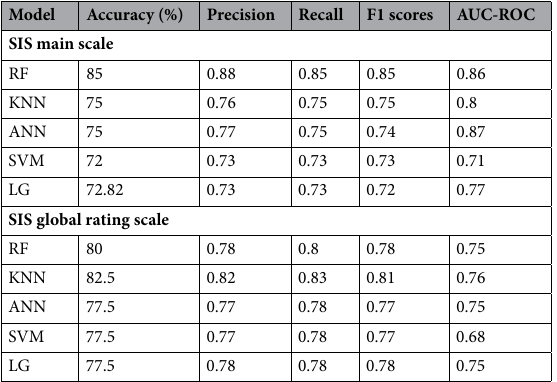
Table 2. Performance metrics of SIS prediction models. SIS Stroke Impact Scale, RF random forest, KNN k-nearest neighbors, ANN artificial neural network, SVM support vector machine, LG logistic regression, AUC- ROC area under the receiver operating characteristic